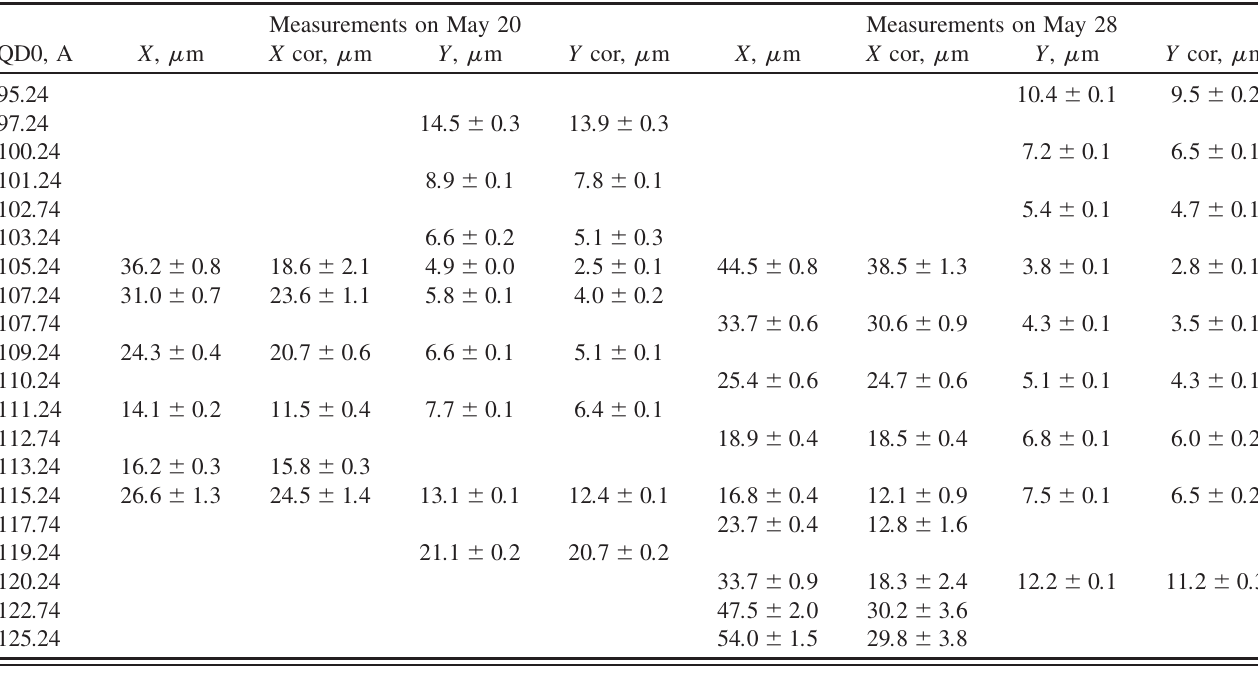
TABLE II. Horizontal and vertical beam sizes measured with post-IP wire scanner without and with correction for wire size and dispersion. The uncorrected beam size errors are statistical uncertainties from fitting Gaussians to the bremsstrahlung photon distributions, while the corrected beam size errors include also uncertainties from the wire size and dispersion subtraction.